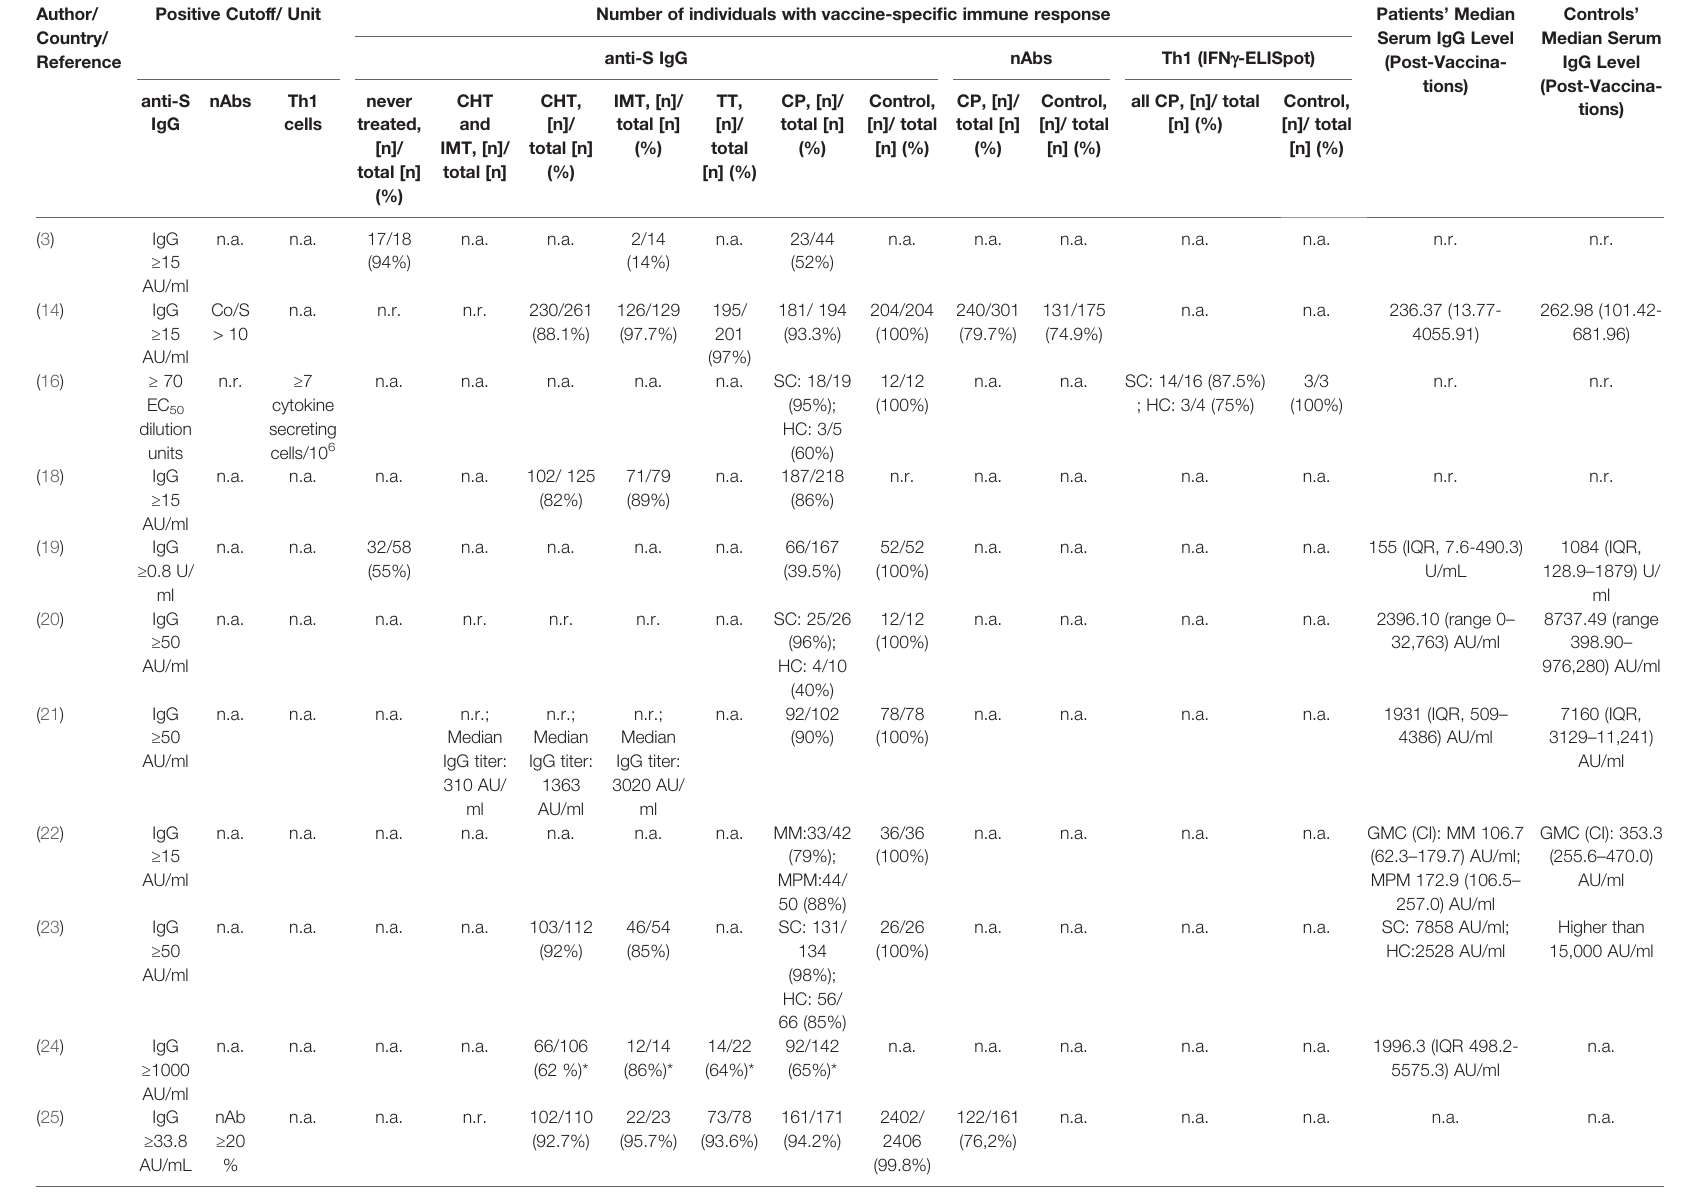
TABLE 3 | Summary of immune responses of COVID-19 vaccination trials in cancer patients under diverse therapies. Author/